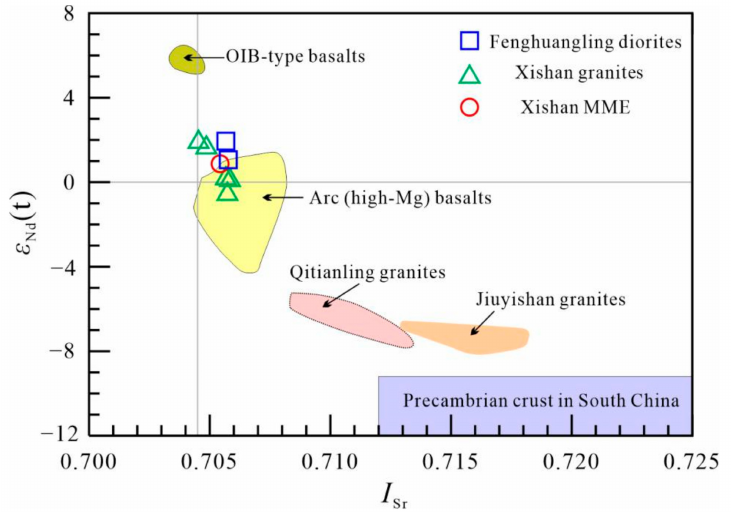
Figure 7. ε Nd(t) versus I Sr diagram of the Guiping complex. Data sources: